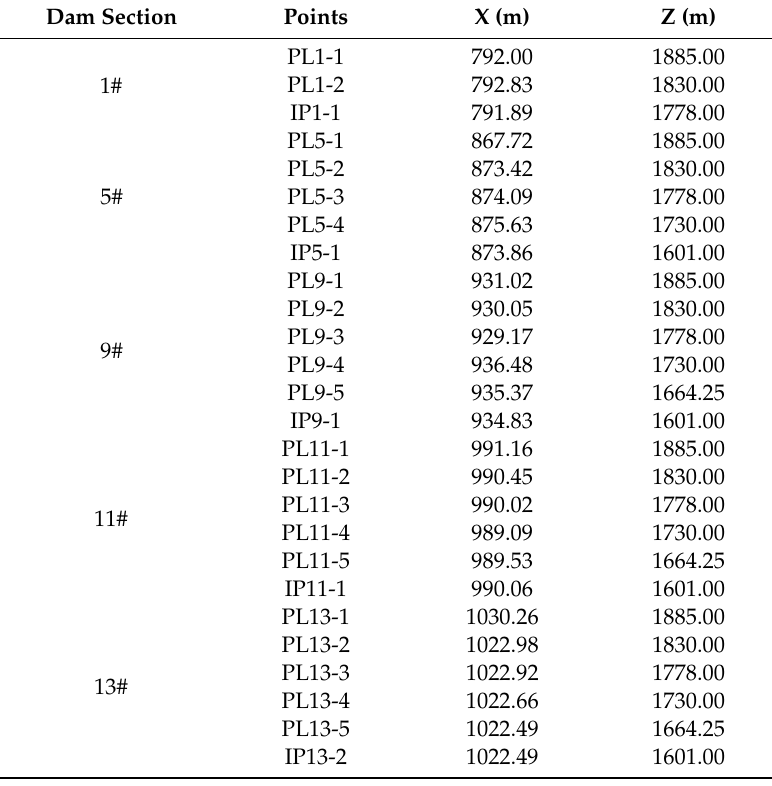
Table 9. Spatial location of measurement points in spatiotemporal hybrid